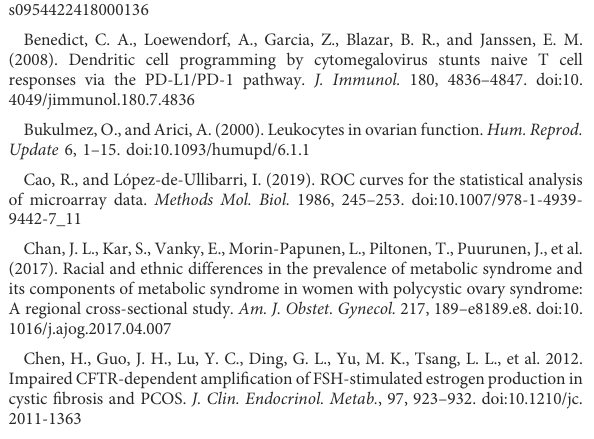
SUPPLEMENTARY FIGURE S2 Determine soft-threshold power for WGCNA.: Left: Analysis of the scale- free fi t index for various soft-threshold powers β . Right: Analysis of the mean connectivity for various soft-threshold powers. SUPPLEMENTARY FIGURE S3 LASSO regression method for searching the DEGs. The plot determined the Coef fi cient of LASSO regression